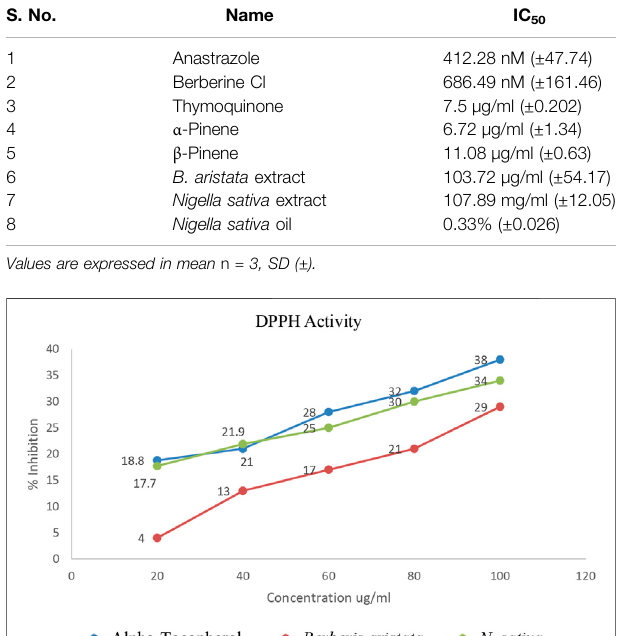
Figure 4G . Graphical data of standard thymoquinone and the N.